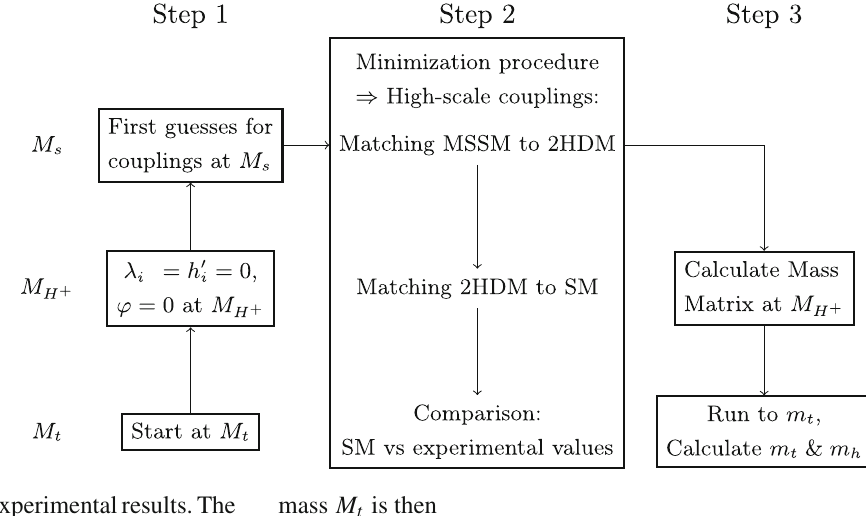
Fig. 2 Pictorial description of the mass